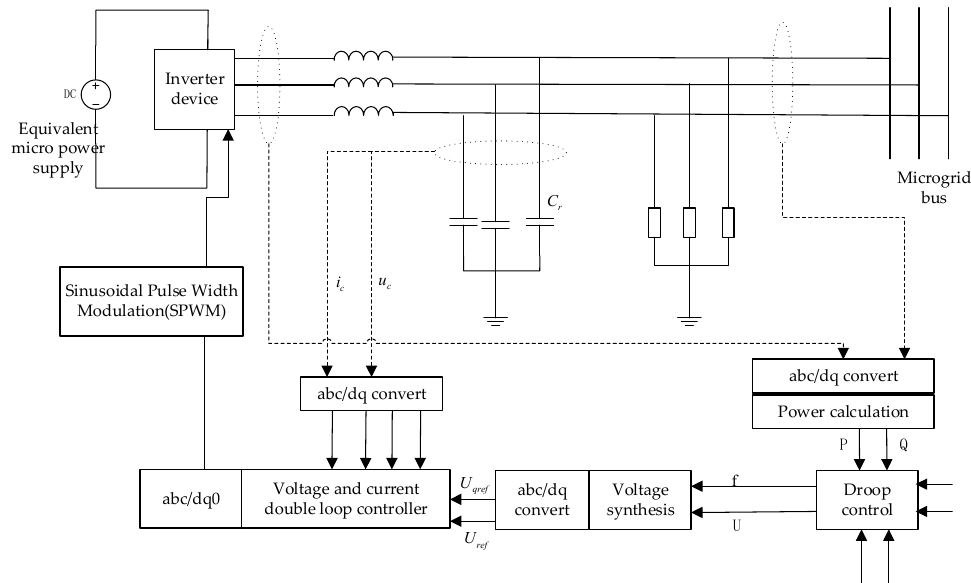
Figure 1. Block diagram of traditional droop control used in three-phase full-bridge inverter.